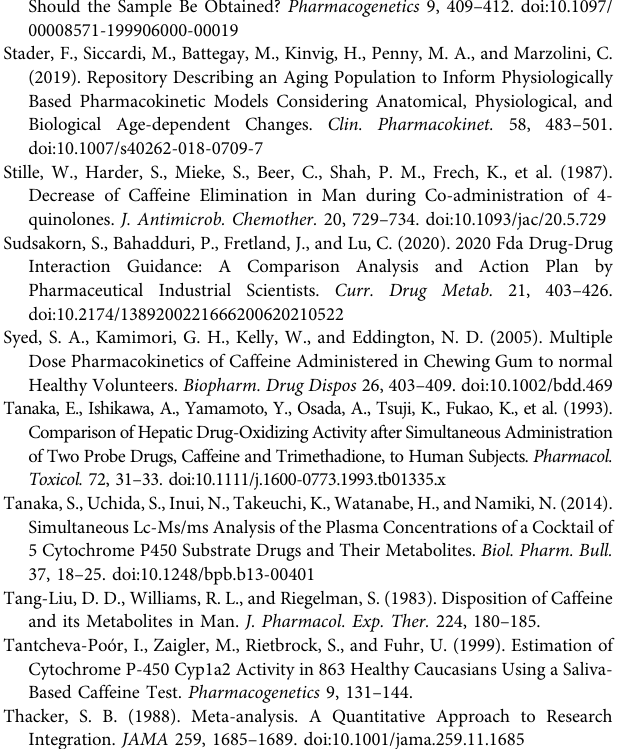
Caffeine: a Model Compound for Measuring Liver Function. Hepatology 4, 38 – 46.